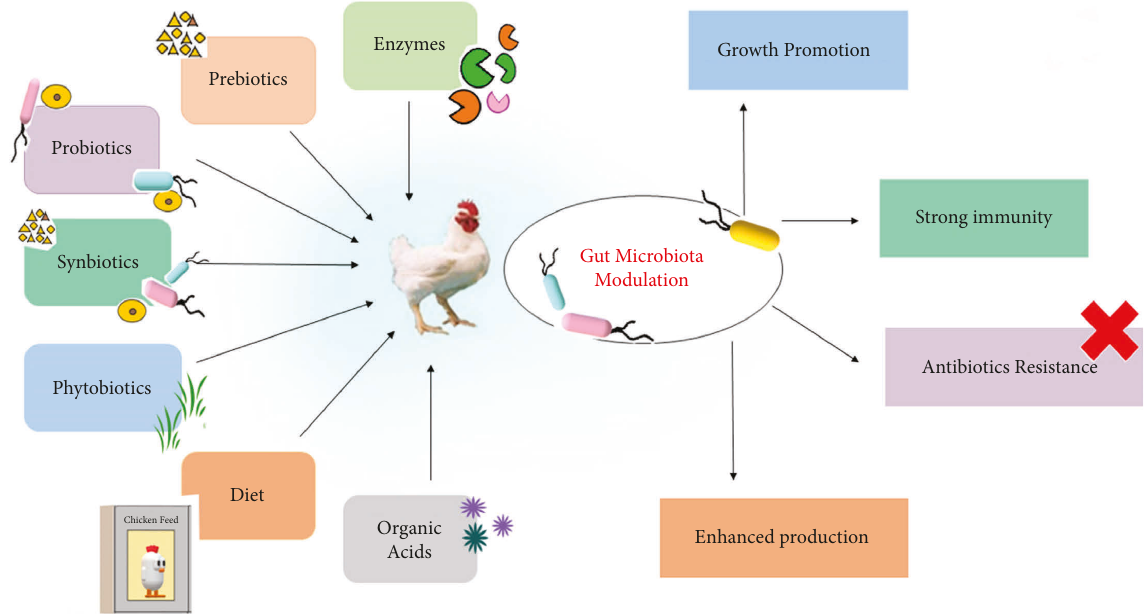
Figure 1: A schematic diagram of gut microbiota and introduction of different regulators involved in different